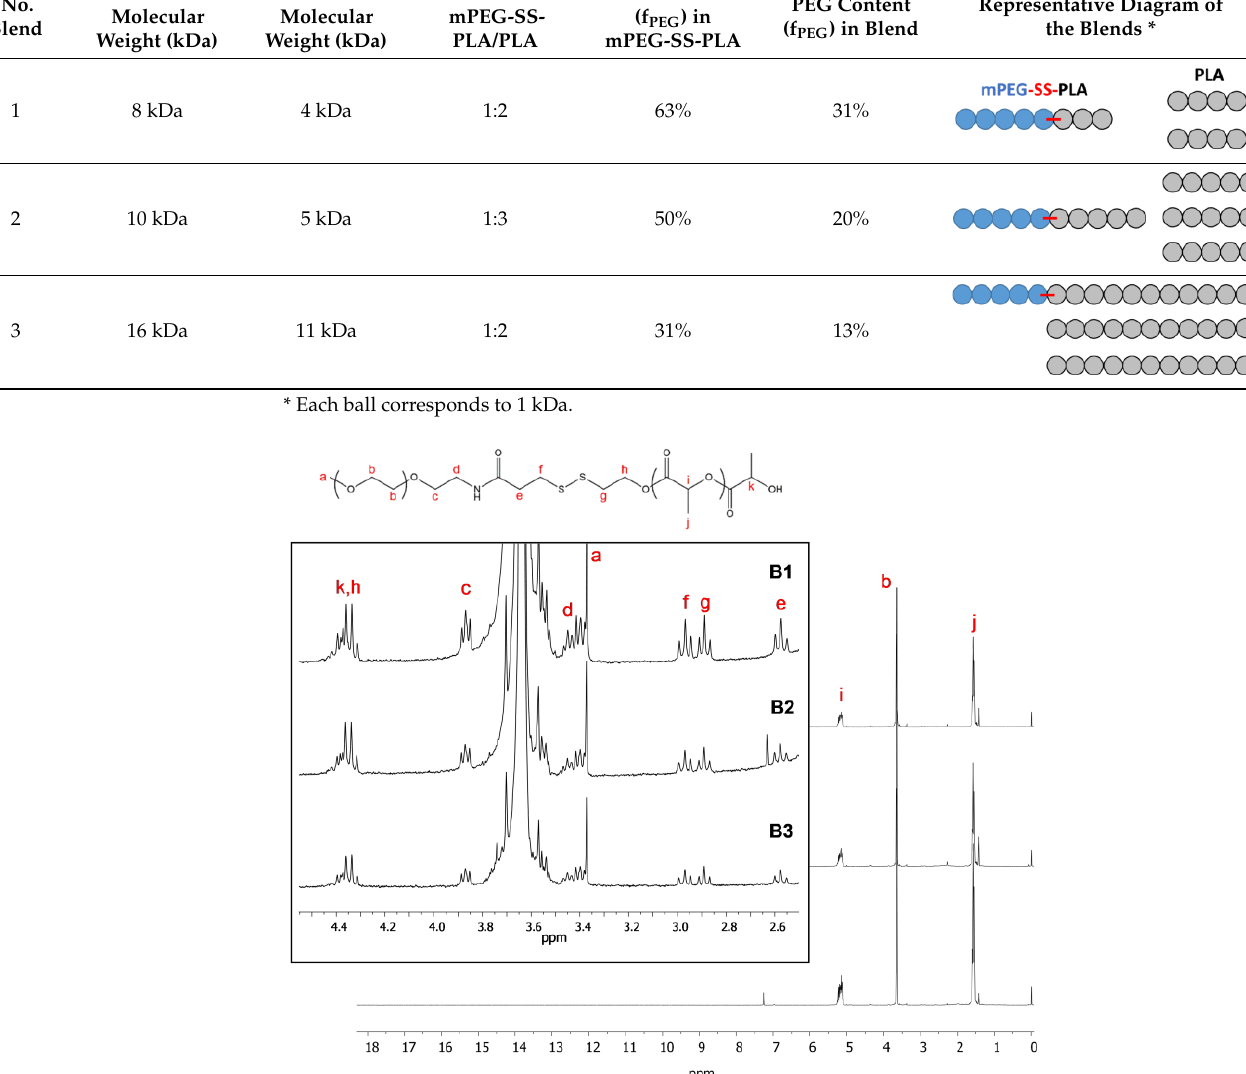
Figure 2. 1 H NRM spectrum of blends 1, 2 and 3 (step 3, CDCl 3 , 25 °C).